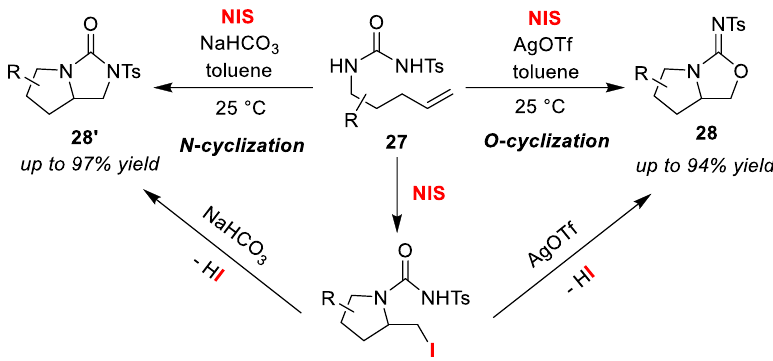
Figure 15. Synthesis of bicyclic iso-ureas 28 and ureas 2 8′ via the O/N atom-selective iodo-cyclizations of olefinic N -tosyl-ureas 27 using NIS and additives.